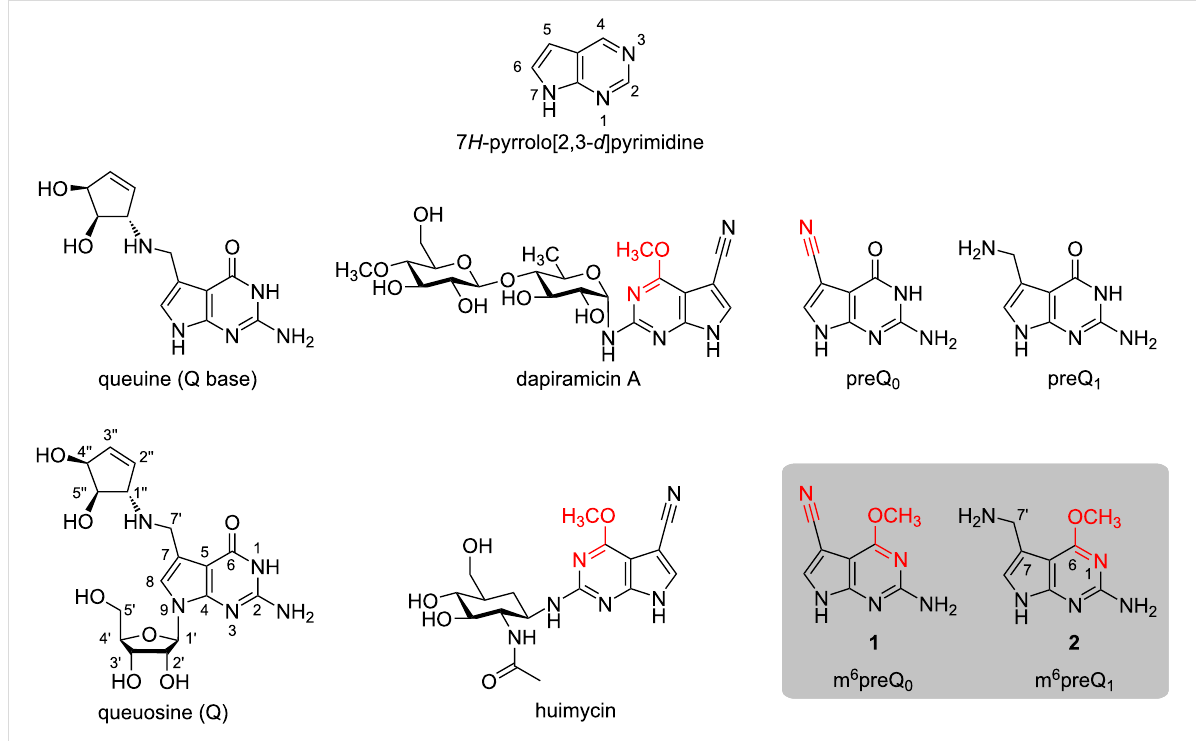
Scheme 1: Chemical structures of queuine (Q base) and the hypermodified nucleoside queuosine (Q), the natural products dapiramicin A and huimycin, as well as intermediates of queuosine biosynthesis (preQ 1 and preQ 0 ), and the major synthetic targets of this study, m 6 preQ 0 ( 1 ) and m 6 preQ 1 ( 2 ) (grey